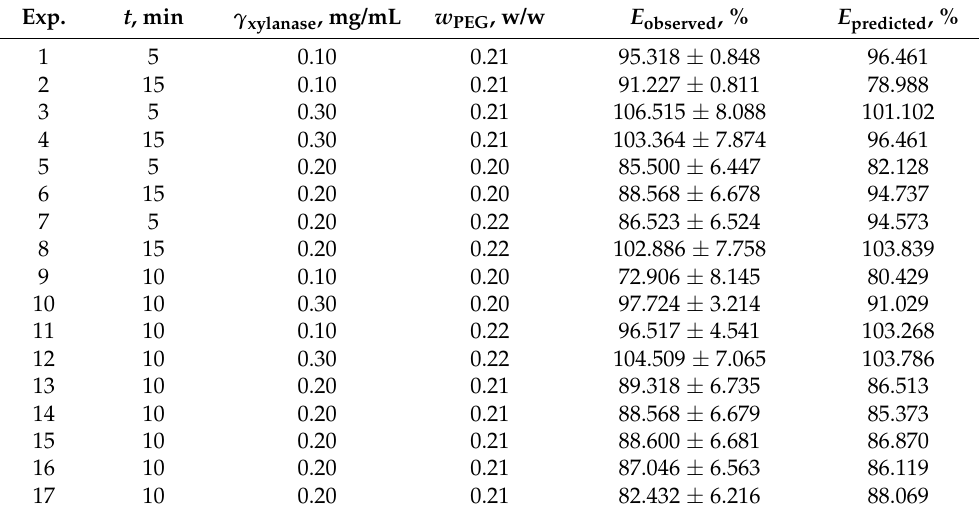
Table 3. Experiment plan according to the Box-Behnken design obtained in the Statistica 13.0 software package and experimentally observed extraction efficiencies and RSM model predicted extraction